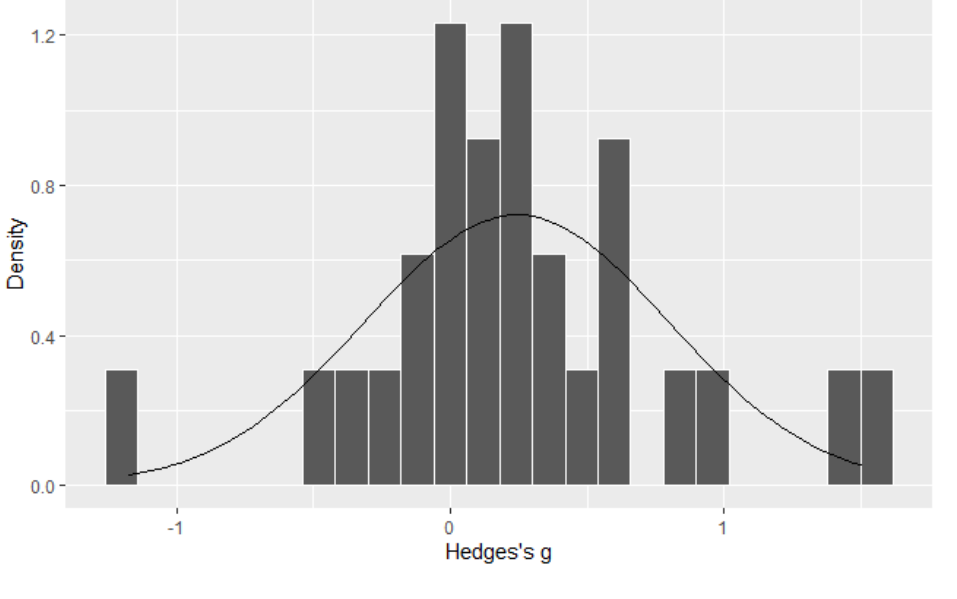
Overall Effect Size Estimates for the Four Conditions